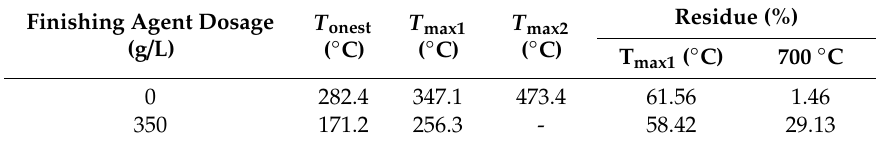
Table 2. Thermogravimetric (TG) data of untreated and treated cotton fabrics in air